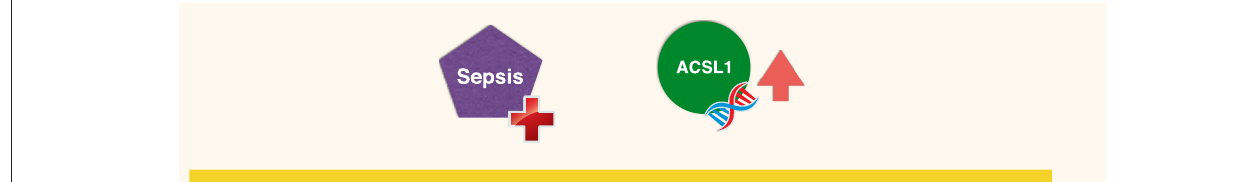
Frontiers in Immunology | www.frontiersin.org